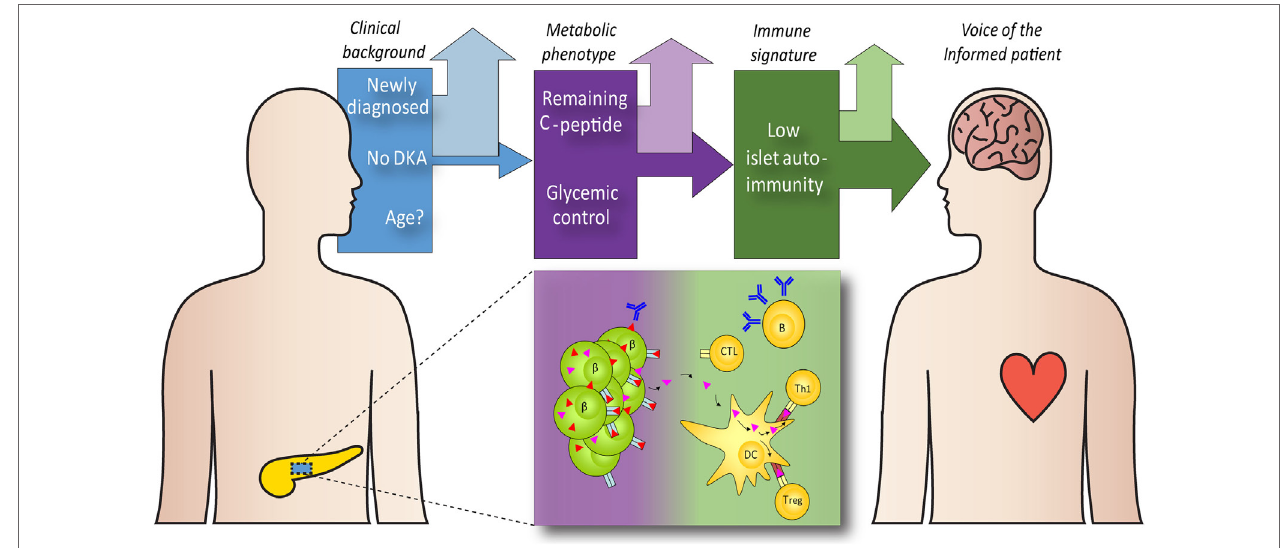
FiGURE 1 | Guidance on the selection of type 1 diabetes (T1D) patients for autologous hematopoietic stem cell transplantation (aHSCT). aHSCT is unlikely to benefit all T1D patients. Factors that may help selecting the preferred candidates include the clinical background [disease duration, age, and diabetic complications, such as diabetic ketoacidosis (DKA)], metabolic features [remaining functional beta-cell mass ( β ) , glycemic control, HbA1c] and immunopathogenic features [the number and type of islet autoantibodies, the frequency and specificity of islet-autoreactive cytotoxic T lymphocytes (CTL), and other effector (Th1) and regulatory (Treg) immune cells, and cytokine profiles]. With the opportunity to identify patient subgroups with particularly great or smaller chances for clinical benefit, we propose that we engage the patient community to guide shared